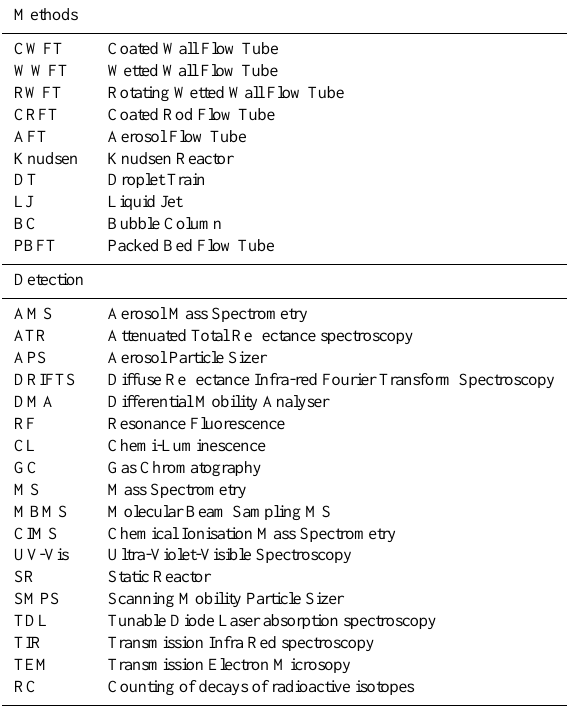
Table 2. Techniques used to study heterogeneous